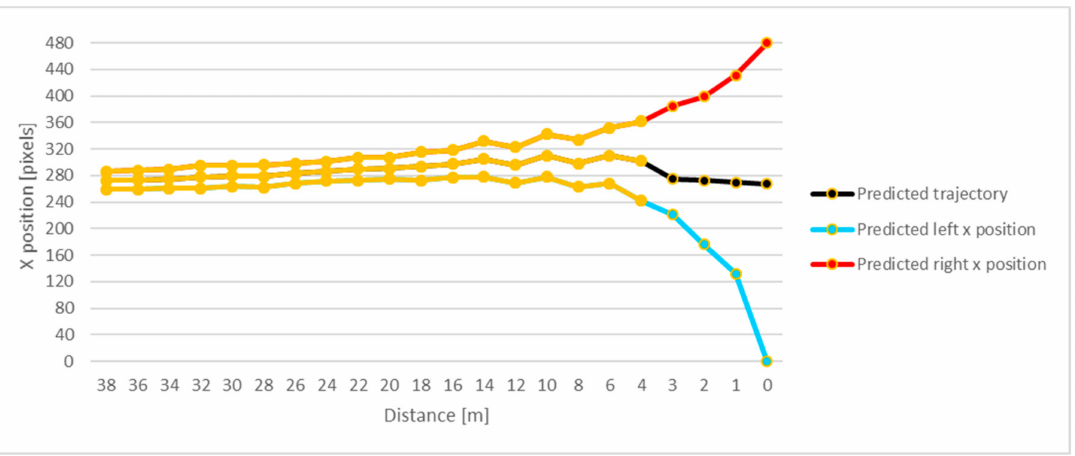
Figure 10. Predicted human movement